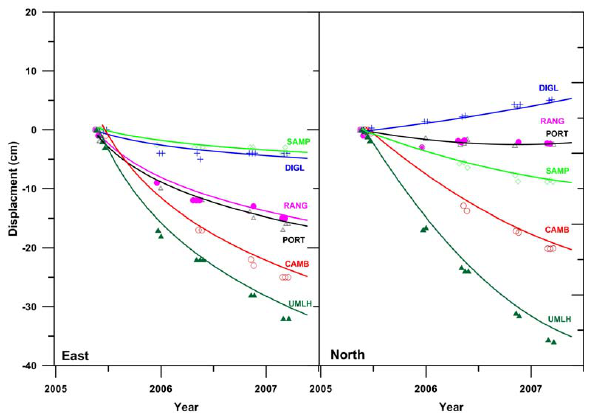
Fig. 2 Postseismic transients in east and north components at six GPS sites: DIGL, RANG, PORT, CAMB, UMLH and SAMP. Four sites (except UMLH and SAMP) are Fig. 2. Postseismic transients in horizontal (east and north) com- located in Andaman and Nicobar region as shown in Fig. 1. The solid lines are exponential ponents at six GPS sites: DIGL, RANG, PORT, CAMB, UMLH fits to the observed data points of the postseismic transients. and SAMP. Four sites (except UMLH and SAMP) are located in the To investigate the contribution of postseismic deformation due to viscoelastic Andaman and Nicobar region as shown in Fig. 1. The solid lines relaxation, we adopted semi-analytical approach by Pollitz, 1997 (VISCO1D), considering are exponential fits to the observed data points of the postseismic stratified earth model and coseismic fault plane solution (Reddy et al., 2010). The layered- earth model parameters (shear modulus, bulk modulus and density) are based on PREM (Dziewonski and Anderson, 1981) which shows three major discontinuities at depths of 65